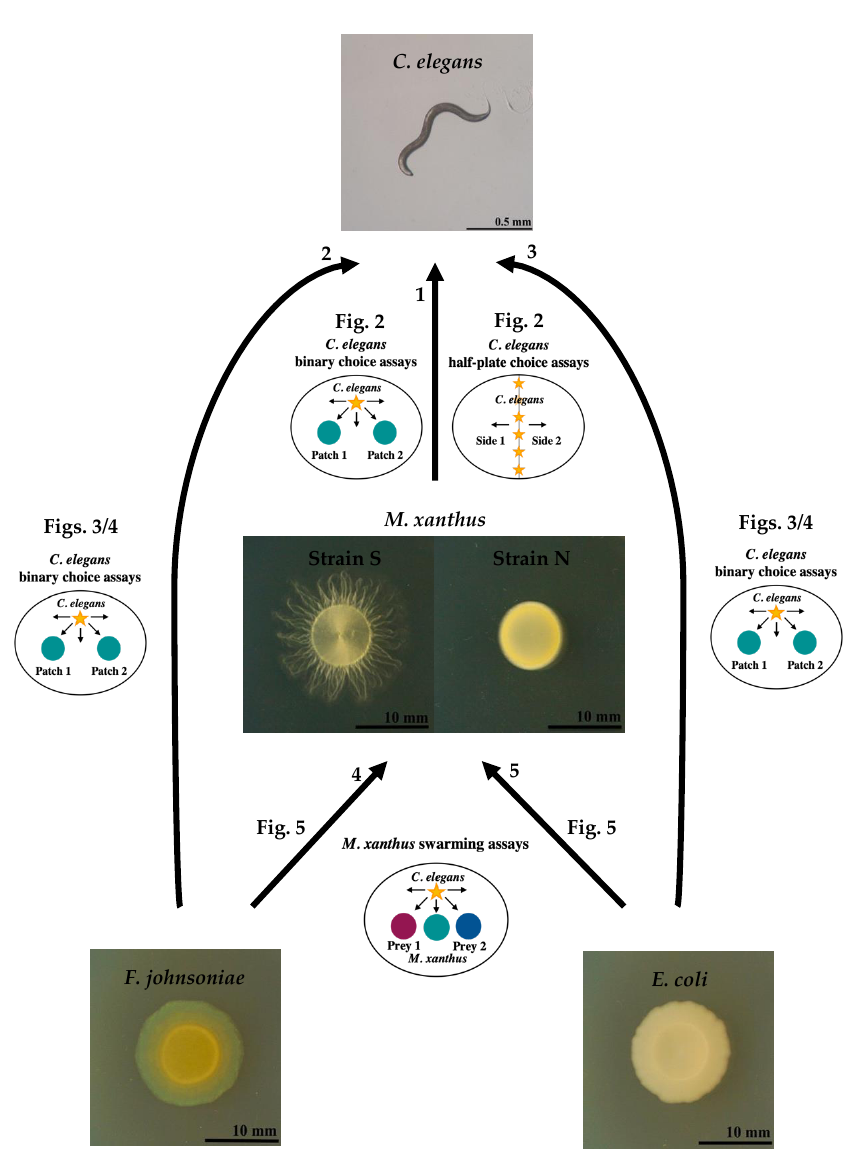
Figure 1. Predicted trophic interactions of the synthetic community and illustrations of experi- mental designs. We predicted that C. elegans might function as a potential apex predator in this food web, preying on all other members of the synthetic community (arrows 1, 2, and 3). We predicted M. xanthus to function as a mesopredator that preys upon both basal prey species (arrows 4 and 5) and to experience predation pressure from the nematode apex predator (arrow 1). We show illustrations of the experimental designs that were used to test each depicted interaction and reference the figures that report the relevant results.